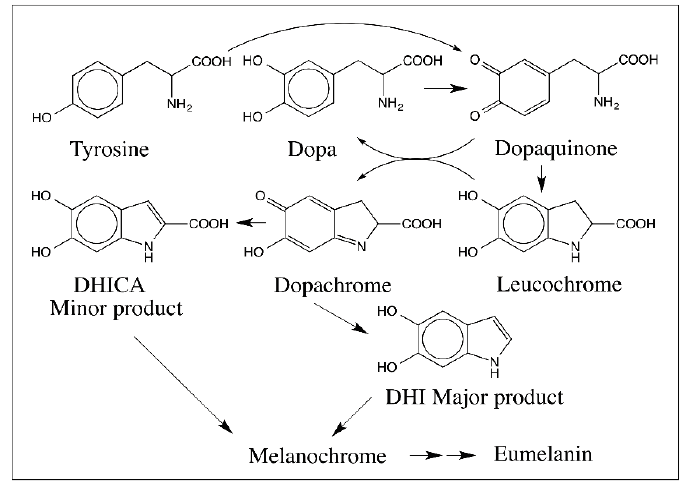
Figure 1. Raper–Mason Pathway for the biosynthesis of eumelanin. Tyrosinase converts tyrosine to dopaquinone via dopa However, dopa is not formed directly from tyrosine but indirectly by the reduction of dopaquinone. Dopaquinone undergoes intrmolecular cyclization producing leucochrome nonenzymatically, which is further oxidized to dopachrome by dopaquinone. Dopachrome is converted to 5,6-dihydroxyindole (DHI) as the major product and 5,6-dihydroxyindole-2-carboxylic acid (DHICA) as the minor product. Further oxidation of DHI to melanochrome and its eventual polymerization leads to melanin pigment.